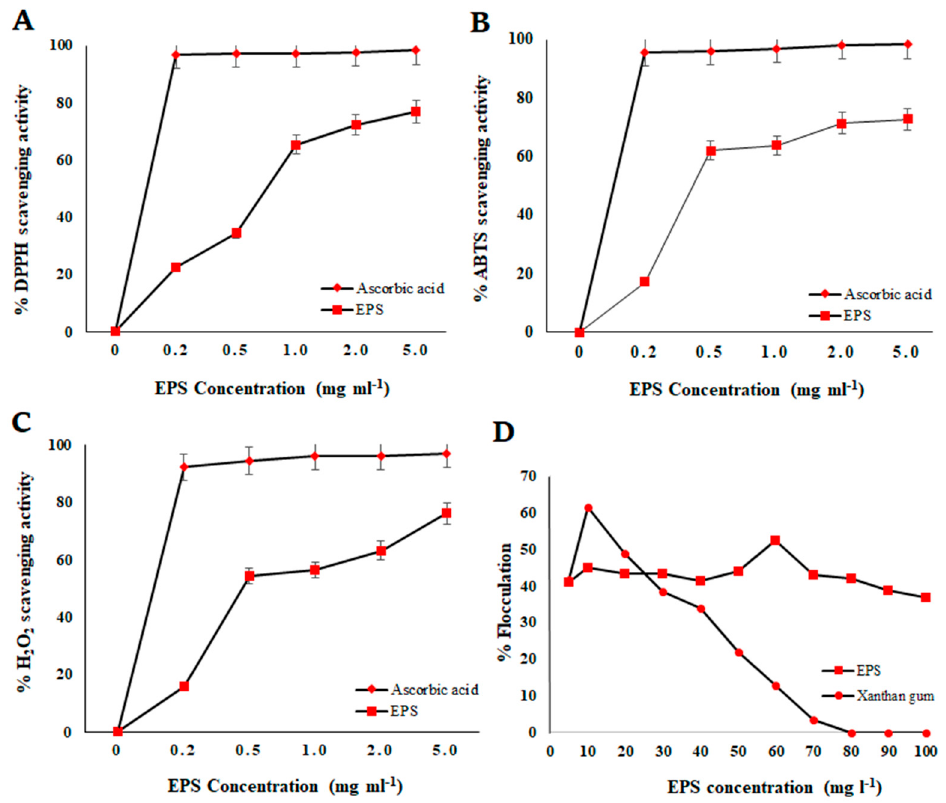
Figure 9. In vitro antioxidant capability of the EPS produced by B. haynesii CamB6; where ( A ) DPPH radical scavenging activity; ( B ) ABTS radical scavenging activity; ( C ) H 2 O 2 radical scavenging activity; and ( D ) Bioflocculation activity of the EPS.